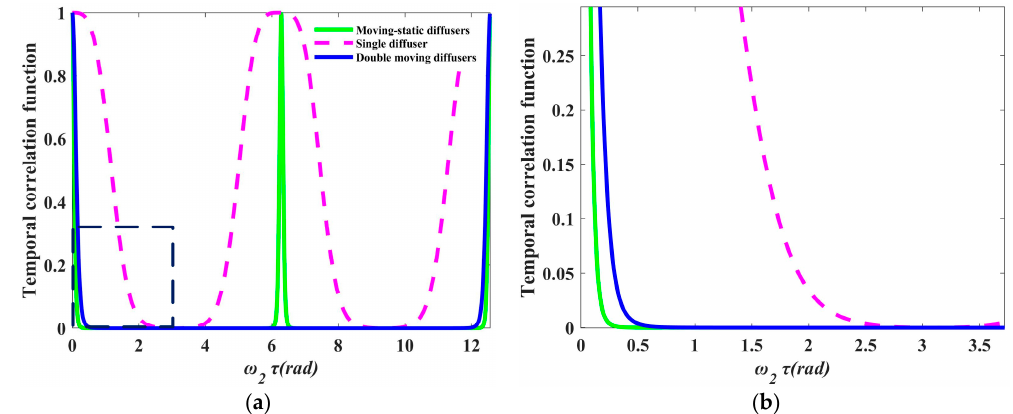
Figure 4. Temporal correlation functions in three different diffusers cases when υ = 0.01. ( a ) Temporal correlation function curve; ( b ) Enlarged region labeled in Figure 4a.